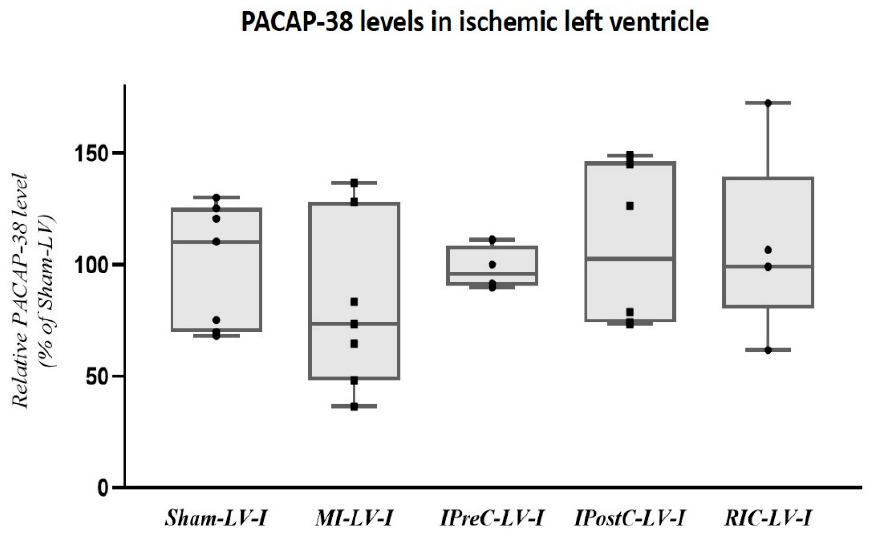
Figure 4. Differences between the tissue PACAP-38 levels of the Sham-operated (Sham), myocardial infarction (MI) alone and combined with ischemic conditioning methods: ischemic preconditioning (IPreC); ischemic postconditioning (IPostC); remote ischemic conditioning (RIC). There was no significant difference in PACAP-38 level in the ischemic zone of left ventricle between groups. The boxes show the interquartile ranges, and the whiskers indicate the most extreme observations. The middle line within the boxes represents the median values. Individual values are presented as black dots and squares. One-way ANOVA with Bonferroni’s post-hoc test. n = 4–8.